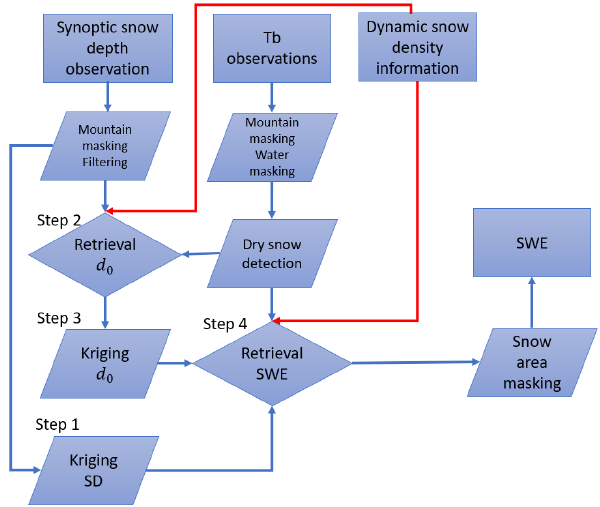
Figure 2. Processing chain of the updated SWE retrieval algorithm. The addition of dynamic snow density information is indicated with red arrows. The four main steps described in Sect. 3.1 are labelled in the